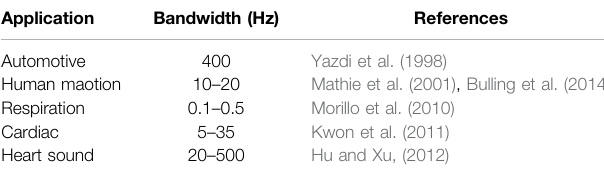
TABLE 1 | Signal bandwidth for accelerometer